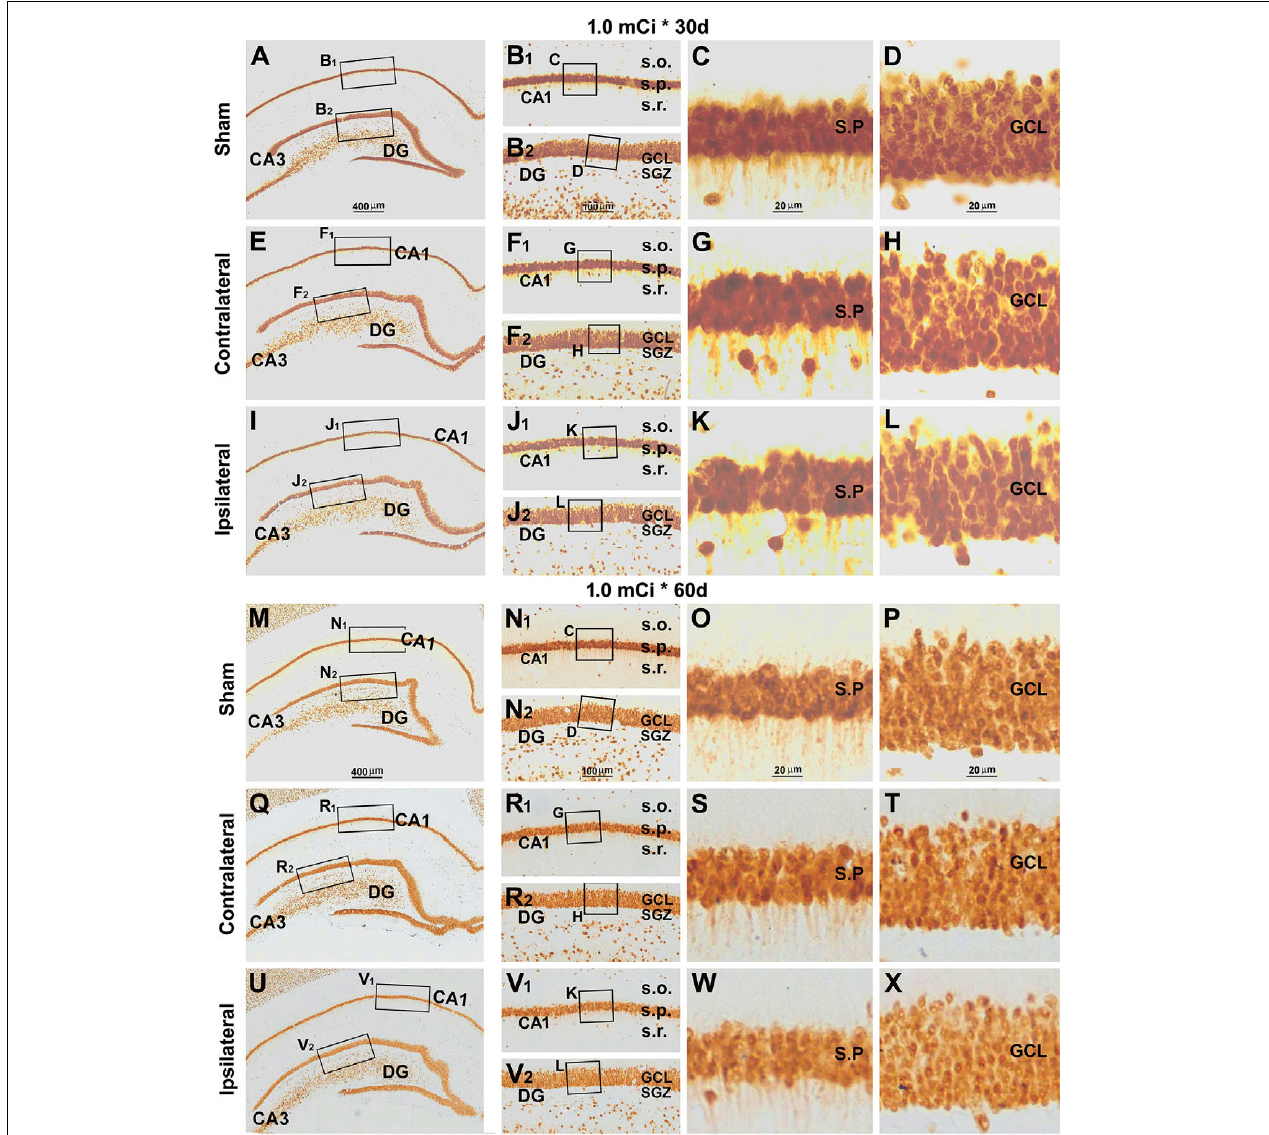
FIGURE 9 | Lack of overt alteration in NeuN immunolabeling in the granule cell and pyramidal layers in animals with 1.0-mCi 125 I seed radiation for 30 and 60 days relative to the sham control. The left panels are low-magnification images showing the orientation of Ammon’s horn (CA1, CA3) and dentate gyrus (DG), with framed areas enlarged sequentially as the middle and right panels, as indicated. NeuN-immunolabeled nuclei appear somewhat less densely packed in the GCL and the s.p. of CA1 in the radiated animals, more so in the 60-day surviving group (right panels). Abbreviations are as defined in Figures 2, 7 . Scale bar = 400 µ m in (A) applying to (E,I,M,Q,U) ; equal to 100 µ m for (B1,B2,F1,F2,J1,J2,N1,N2,R1,R2,V1,V2) ; and 25 µ m for (C,D,G,H,K,L,O,P,S,T,W,X)